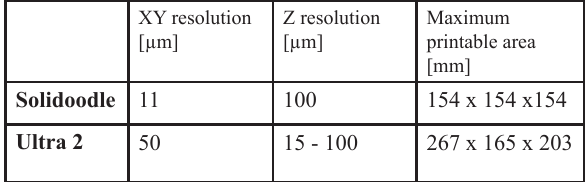
Table 2: comparison between two solid printers